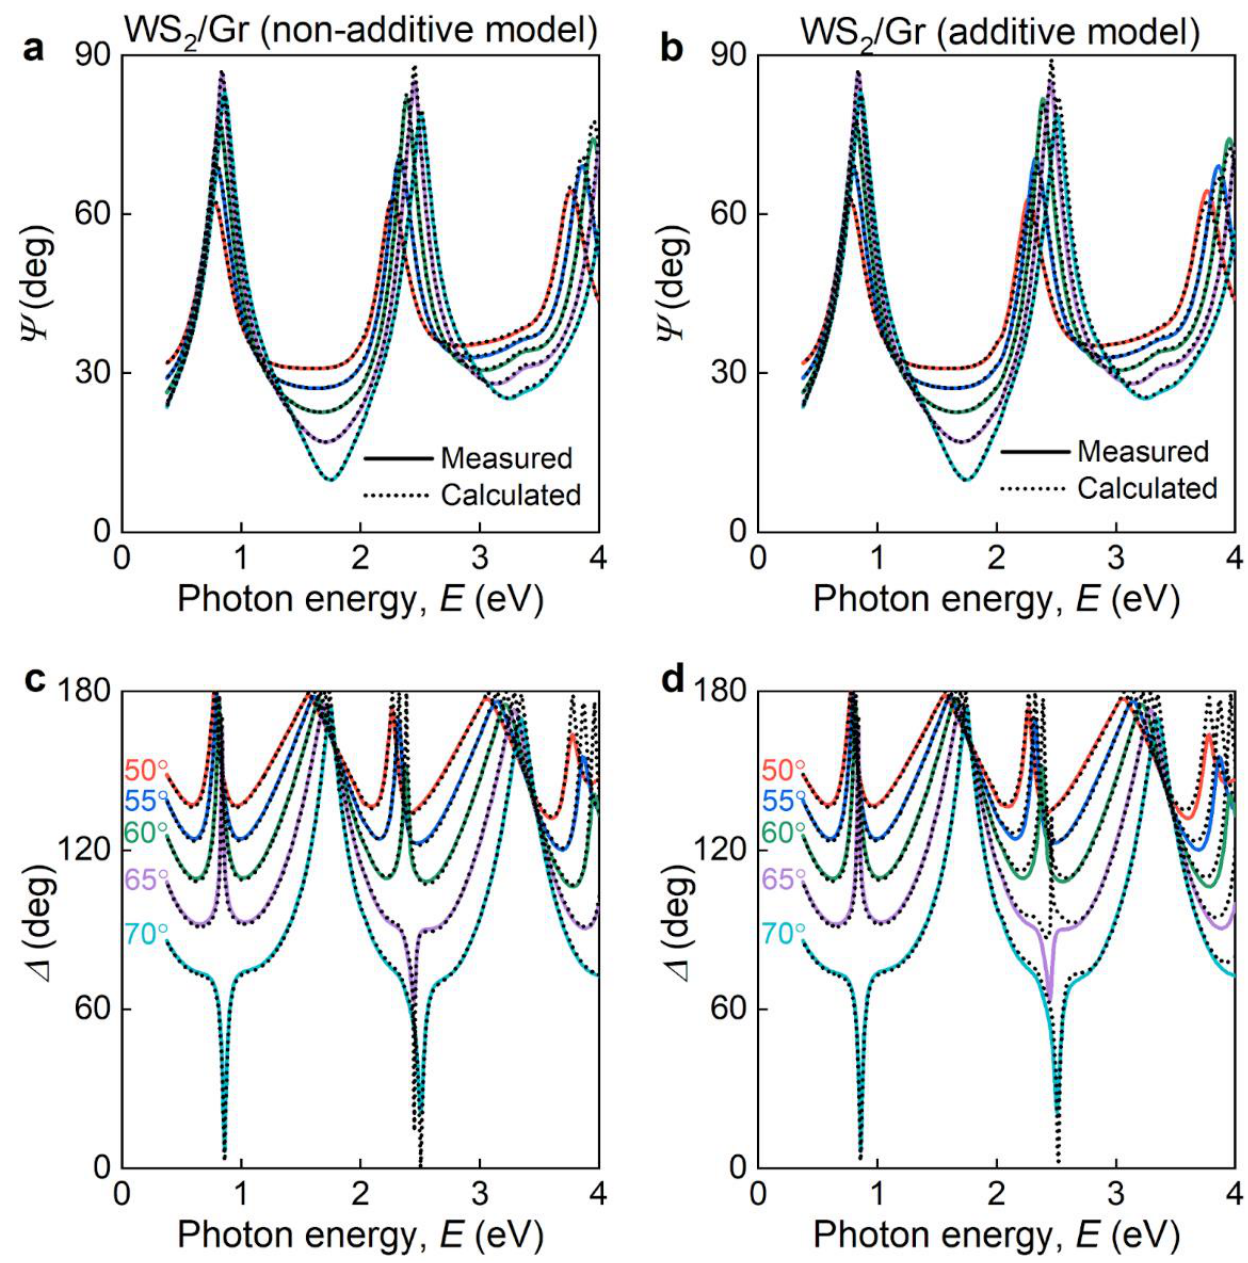
Figure A3. Ellipsometry spectra of WS 2 /Gr heterostructures. Comparison of non-additive and additive optical models for ( a , b ) Ψ and ( c , d ) ∆ . Red, blue, green, violet, and cyan lines correspond to 50 ◦ , 55 ◦ , 60 ◦ , 65 ◦ , and 70 ◦ incident angles, respectively.